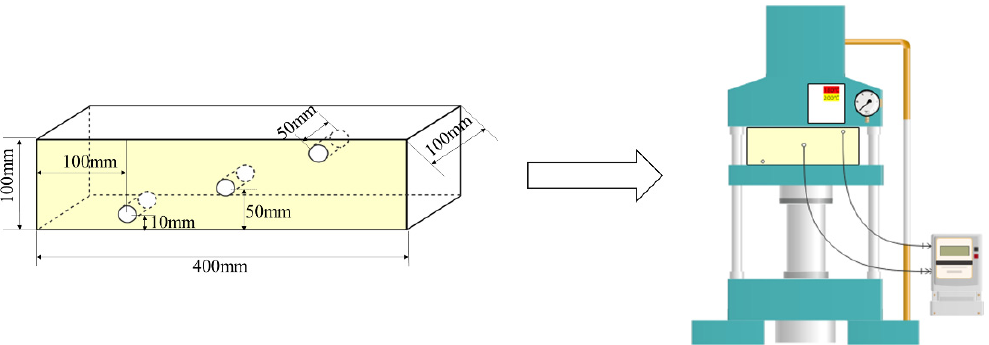
Figure 1. Schematic diagram of thermocouple embedding for in situ sample temperature monitoring during heat treatment.